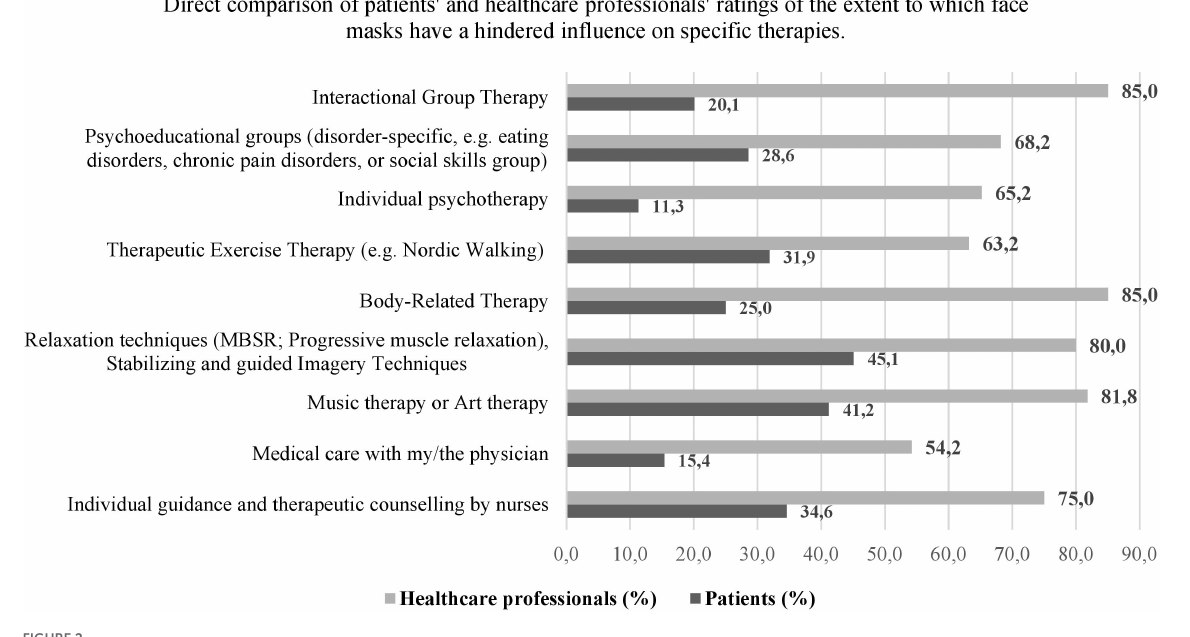
FIGURE2 Illustration of the ratings, shown as percentages of frequency of patients ( n = 55) and healthcare professionals ( n = 28) interviewed regarding a disturbing effect by the face masks on various types of therapy. The percentages refer to the “applicable percentages” of the individual